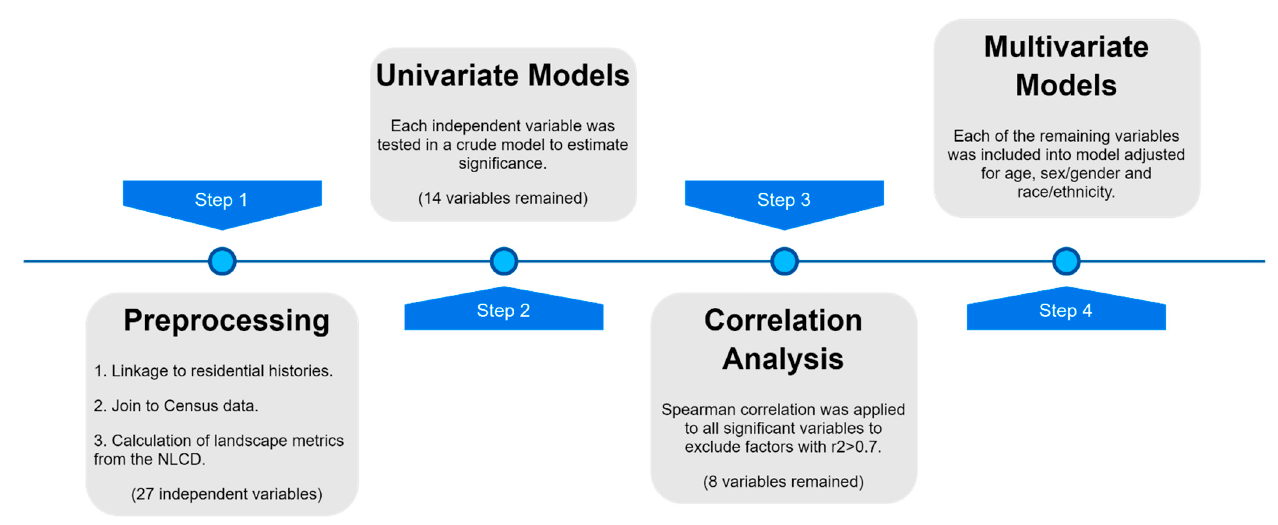
Figure 2. Workflow diagram.